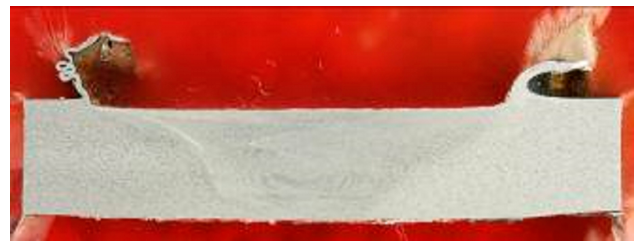
Figure 11. Cross section of the joint which verified the best results in mechanical terms (n = 500 rpm; v = 20 cm/min).